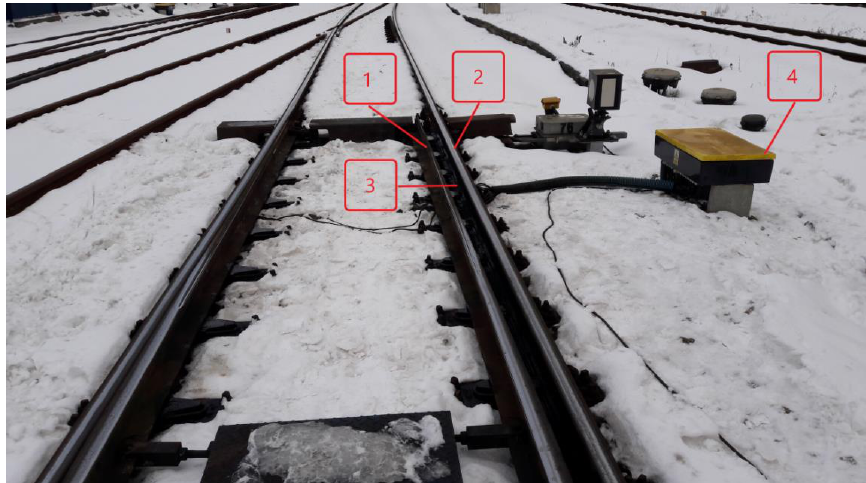
Figure 1. Built-in elements of the turnout electric heating system (1—switch rail, 2—stock rail, 3—working space, 4—separation transformer